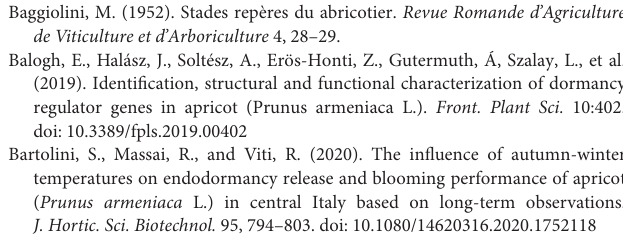
Supplementary Figure 1 | Establishment of endodormancy breaking date (T) in 20 apricot cultivars by analyzing the evolution of the Pearson correlation coefficients between full flowering dates and winter temperatures of periods of 15 days. Discontinuous lines delimit the significant values (0.553, –0.553). Green and red scales show positive and negative coefficients, respectively. Supplementary Figure 2 | Model coefficients of Partial Least Squares regression between accumulation rates of agroclimatic metrics (Chill Portions according to the Dynamic Model and Growing Degree Hours) and bloom dates of 20 apricot cultivars. Top panels show the Variable importance in the projection (VIP), with the blue bars values above 0.8 indicating the threshold for variable importance. Middle panels show the model coefficients of the centered and scaled data. Chilling period is colored in blue and heating period is colored in red. Bottom panels show mean temperatures (black line) and their standard deviation (grey areas). In middle and bottom panels, red and green scales show negative and positive coefficients, respectively. Supplementary Table 1 | Chilling and heat requirements of 20 apricot cultivars determined by the Forcing test. Dates of endodormancy and full flowering, yearly values of chill accumulation expressed in chill portions, chill units, and chill hours below 7 ◦ C, yearly values of heat accumulation expressed in Growing Degree Hours (GDH), mean values, standard deviation (SD), and coefficient of variation (cv). Supplementary Table 2 | Chilling and heat requirements of 20 apricot cultivars determined by the Correlation method. Dates of endodormancy and full flowering, values of chill accumulation expressed in chill portions, chill units, and hours below 7 ◦ C, values of heat accumulation expressed in Growing Degree Hours (GDH), standard deviation (SD), and coefficient of variation (cv). Supplementary Table 3 | Chilling and heating requirements of 20 apricot cultivars determined by the PLS regression method. Chilling and forcing periods are established with Partial Least Squares regression based on the Dynamic Model and the Growing Degree Hours Model. Chill accumulation is expressed in chill portions, chill units, and hours below 7 ◦ C, values of heat accumulation are expressed in Growing Degree Hours (GDH), standard deviation (SD), and coefficient of variation (cv). Supplementary Table 4 | Chilling and heating requirements of 20 apricot cultivars determined by the Male meiosis method. Dates of endodormancy and full flowering, yearly values of chill accumulation expressed in chill portions, chill units, and hours below 7 ◦ C, yearly values of heat accumulation expressed in Growing Degree Hours (GDH), mean values, standard deviation (SD), and coefficient of variation